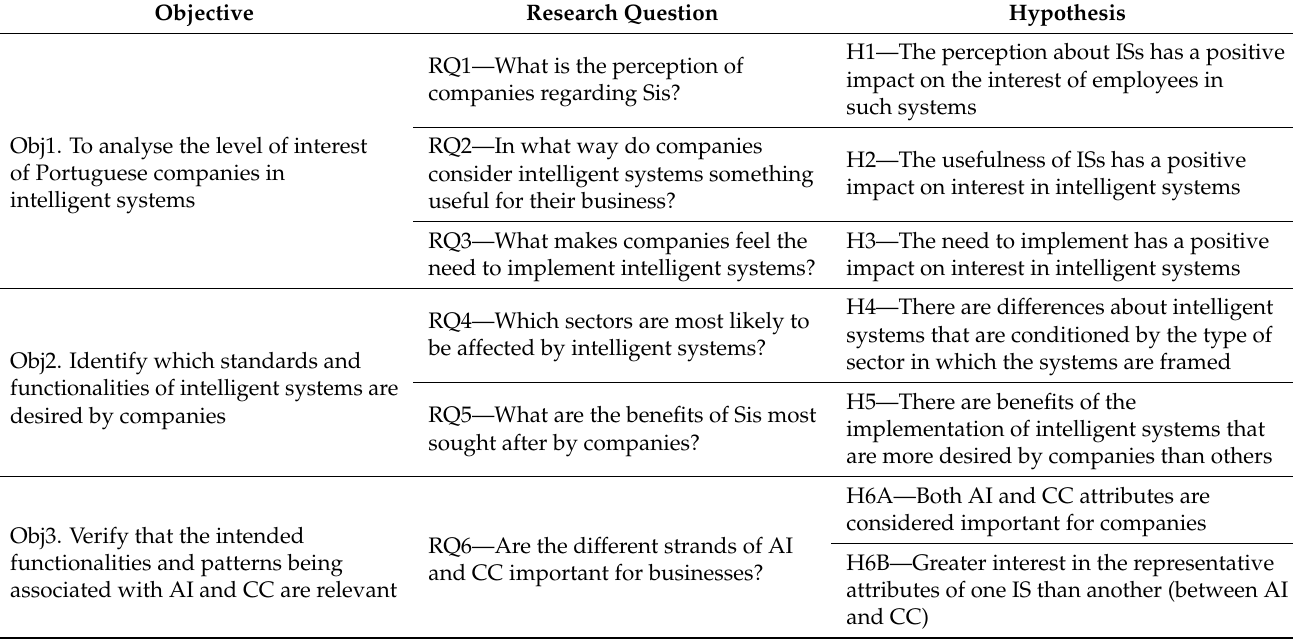
Figure 1. Research model. Source: elaborated by the author. Davenport, 2017 [5,6]; Mallick & Borah, 2019 [10]; Sangaiah et al., 2018 [15]; Agrawal et al., 2019 [16]; Zhang and Dafoe, 2019 [17]; Fast and Horvitz, 2017 [18]; Bhatnagar et al., 2018 [19]; Davenport & Ronanki, 2018 [20]; Chen et al., 2018 [22]. Table 1. Objectives, research questions, and respective hypotheses.